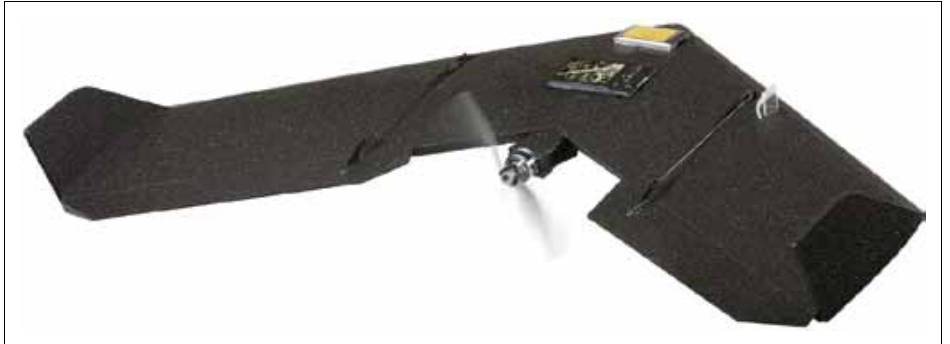
Fig. 6: The swinglet CAM UAV (© senseFly